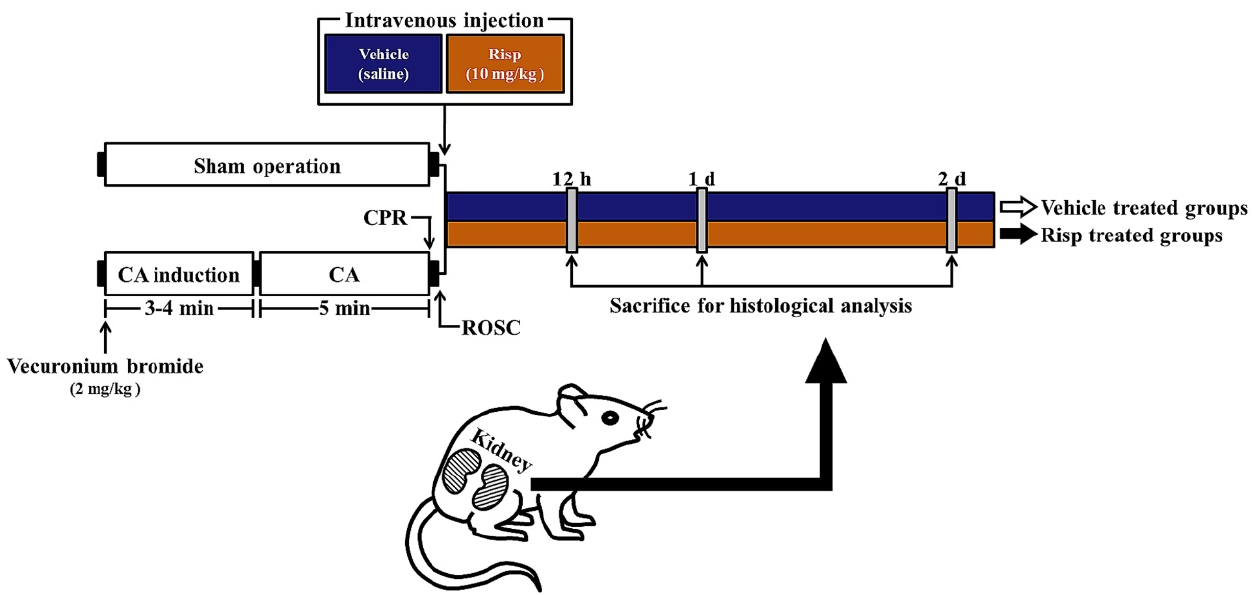
Figure 1. Experimental design and timeline. In this experiment, all rats underwent sham or CA/ROSC operation followed by administration of saline (vehicle) or Risp (10 mg/kg). The rats were profoundly anesthetized and sacrificed at 12 h, one day, and two days after CA/ROSC. Thereafter, the obtained kidneys were used for the analyses. CA, cardiac arrest; CPR, cardiopulmonary resuscitation; ROSC, return of spontaneous circulation; Risp,